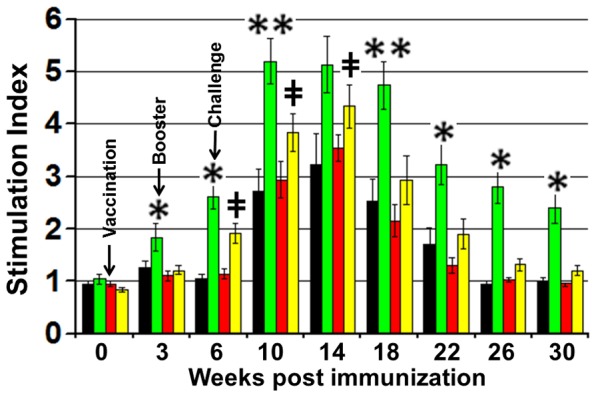
Lymphoproliferation.PBMCs isolated from animals bled at various time points were stimulated with/without Ag-mix (15 μg/ml) or PPDj (10 µg/ml) in 200 ul RPMI for 72 hrs at 37C in a humidified atmosphere supplemented with 5% CO2. The proliferative response was measured by cell proliferation ELISA, BrdU colorimetric kit (Roche Diagnostics, Indianapolis, IN) as per the manufacturer's protocol. The results are expressed as stimulation index (SI), and the error bars indicate 1 standard deviation from the mean. (PBS Vs 316F *indicates p<0.05 ** indicates p<0.01, PBS Vs Sal-Ag ‡ indicates p<0.05 ‡‡ indicates p<0.01).